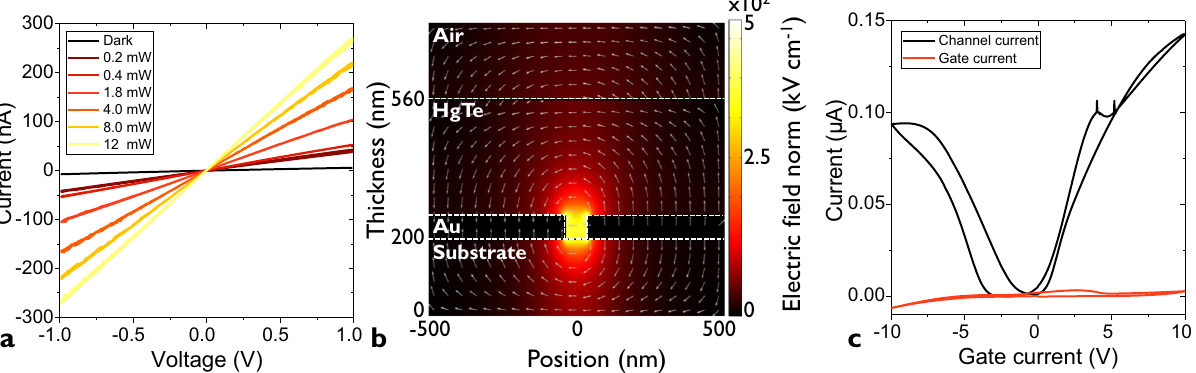
Fig. 2 Electrical characterization of the nanotrench electrodes. a I – V curves for a nanogap functionalized by a HgTe nanocrystal array in the dark and under illumination by a 1.55 µ m laser diode. The experiment is conducted at 200 K. b Simulated electric fi eld color map for a 40-nm nanotrench under a 3 V bias. Arrows represent the direction of the electric fi eld. c Transfer curves (channel and gate current as a function of applied gate bias) for an HgTe nanocrystal array deposited on a nanotrench fabricated on a LaF 3 substrate used as a back gate. The measurement is conducted at 200 K.